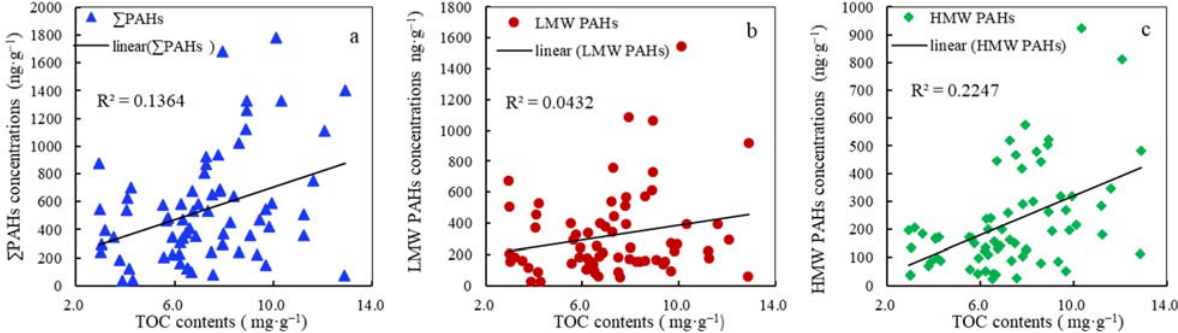
Figure 4. The correlations of TOC contents with ∑ PAHs ( a ), LMW-PAHs ( b ), and HMW-PAHs ( c ) and the correlation coefficient (R 2 ) and significance level (p) are given.